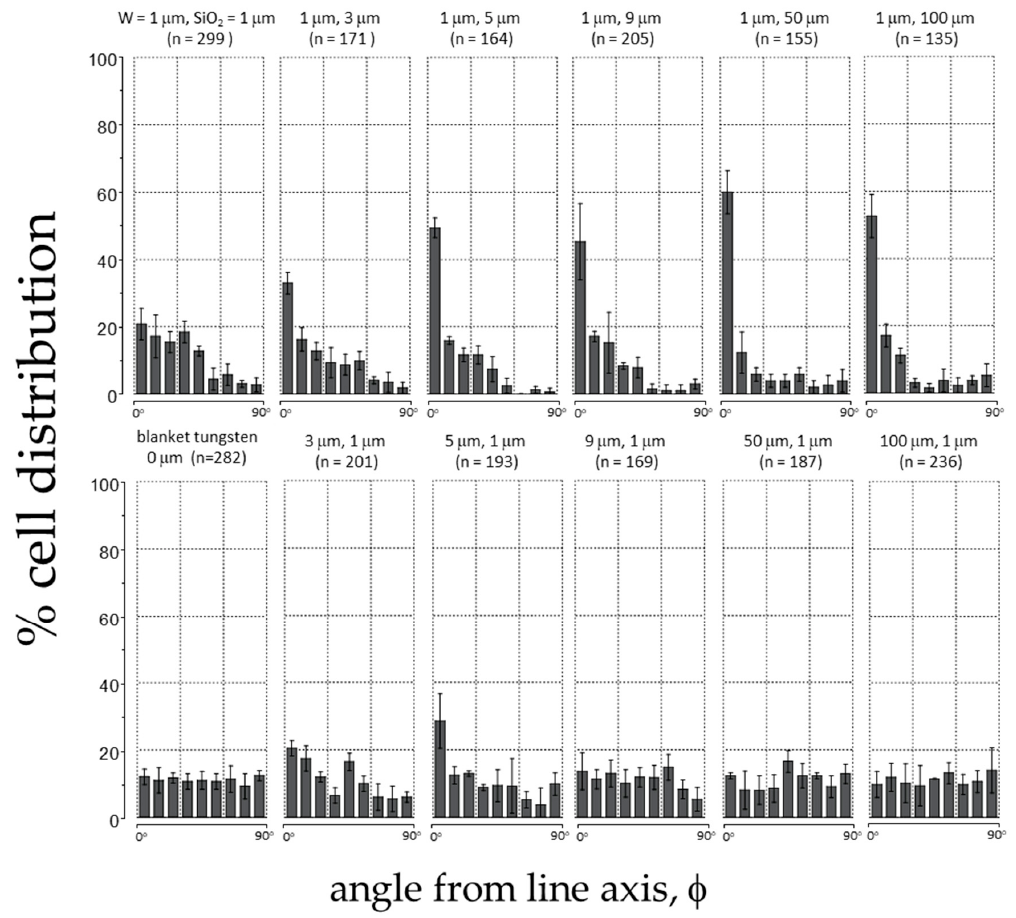
Figure 3. Percent cell distribution of cell orientation relative to the line axes ( φ ) after being incubated on substrates with various tungsten and silicon oxide line widths. Each bin corresponds to the cell population within a 10° angular range.